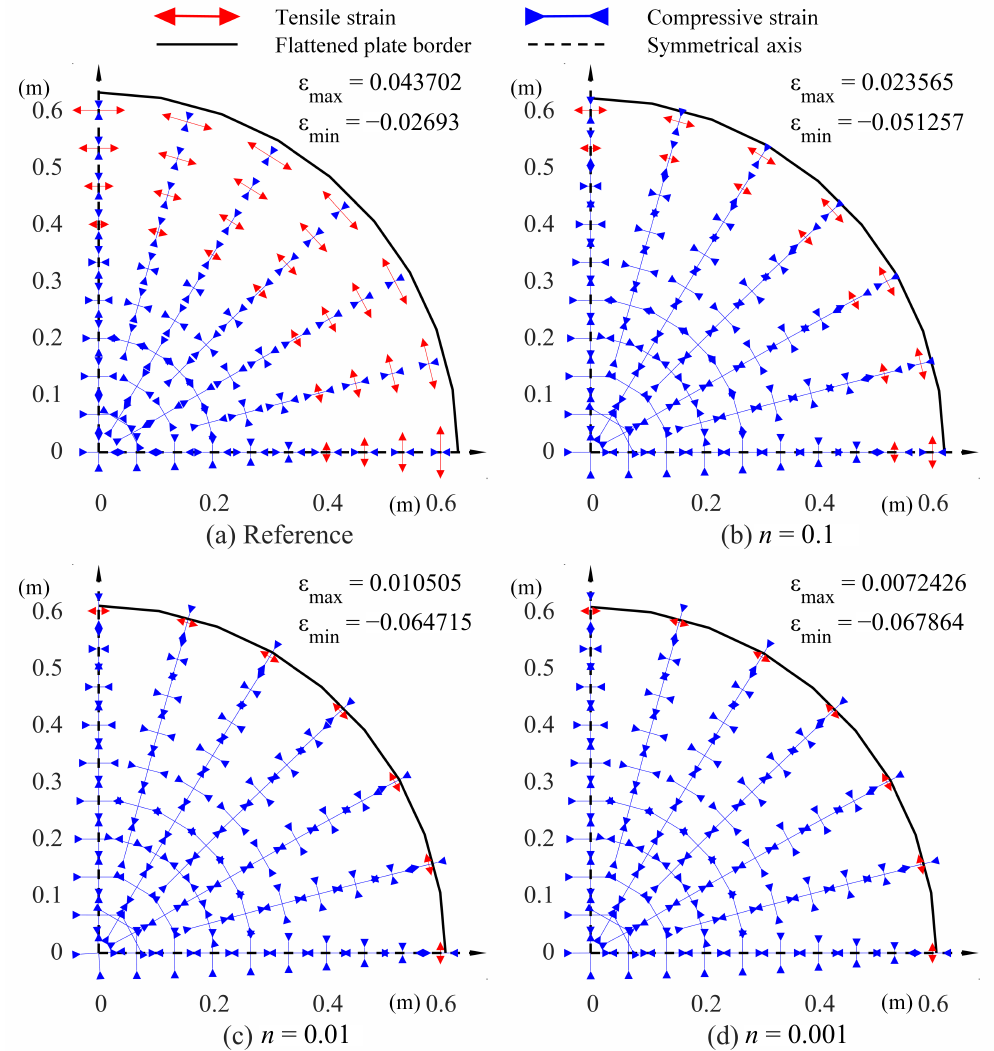
Figure 7. Principal membrane strain vector of spherical cap flattening with dominating compressive strain ( a ) reference, ( b ) n = 0.1, ( c ) n = 0.01, ( d ) n =